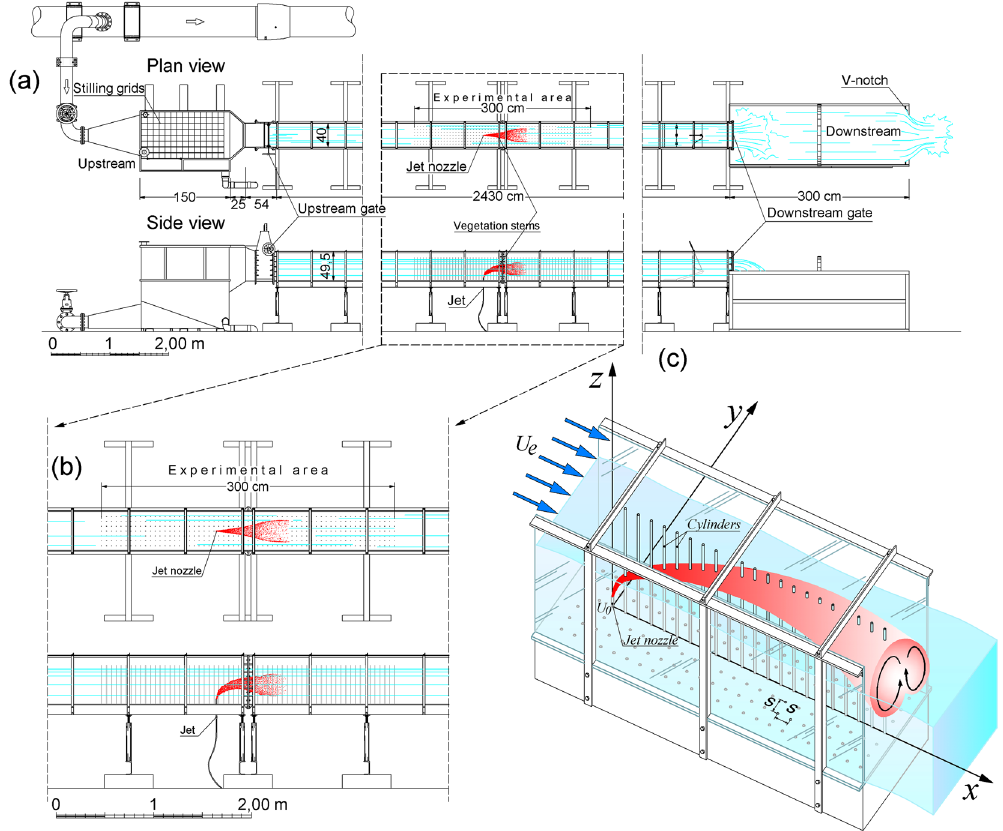
Figure 2. ( a ) Plan and side views of the channel; ( b ) close-up of the experimental area; ( c ) sketch of the jet with the rigid cylinder array (for the sake of clarity some stems are shown only with their projections on the channel bottom) and the coordinate